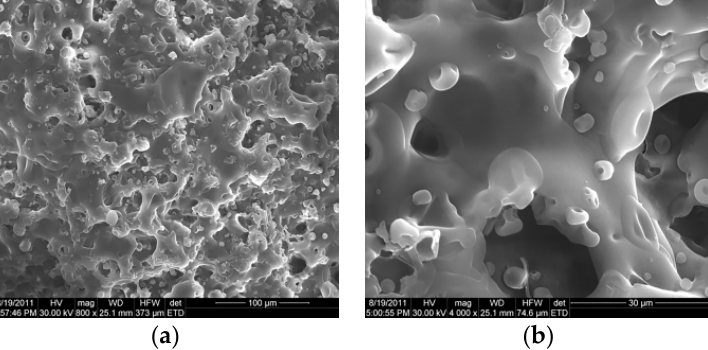
Figure 11. ( a ) Example of SEM image (800 × ) of the surface of MX-EM sample; ( b ) example of SEM image (4000 × ) of the surface of MX-EM sample.